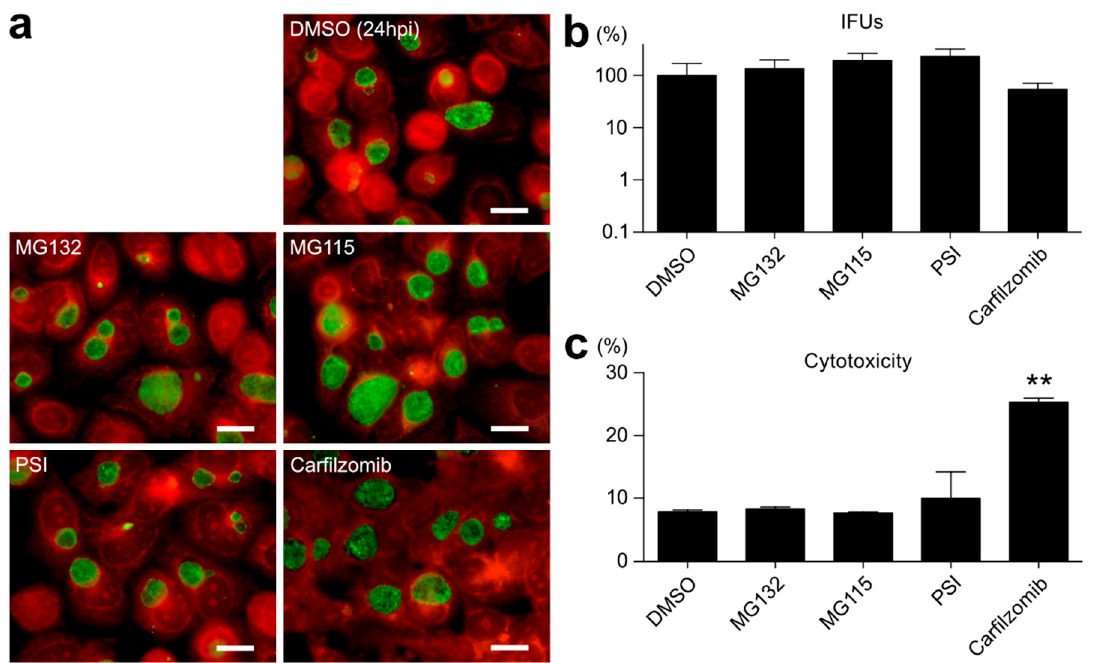
Figure 2. Proteasome inhibitors other than BTZ do not inhibit chlamydial growth. ( a ) C. trachomatis L2-infected cells were separately treated with an indicated proteasome inhibitor (1 µ M each) for 24 h and fixed and immunostained as described in Figure 1. A red stain denotes Evans blue counterstaining. Scale bar, 20 µ m. ( b ) Infected cells were harvested at 48 hpi, and then, the IFU scores were evaluated. ( c ) Cytotoxicities of used chemicals for HeLa cells. Cells were separately treated with chemicals for 48 h (1 µ M each), and the released LDH activity was measured as described in Figure 1i. Data are the mean ± SD of three independent wells. ** p < 0.01 compared to each control sample by Welch’s t -tests.